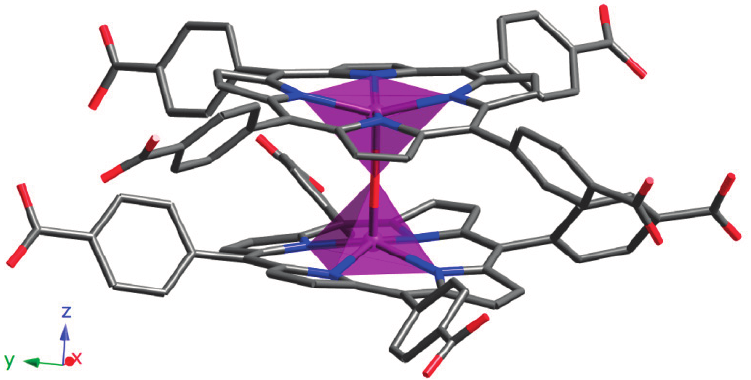
Figure 2. ( a ) View of the H-bonded 2D supramolecular layer and ( b ) packing for compound 1 . (Cu: green, C: grey, N: dark blue, O: red, crystallization DMF molecules: yellow). H atoms have been omitted for clarity.